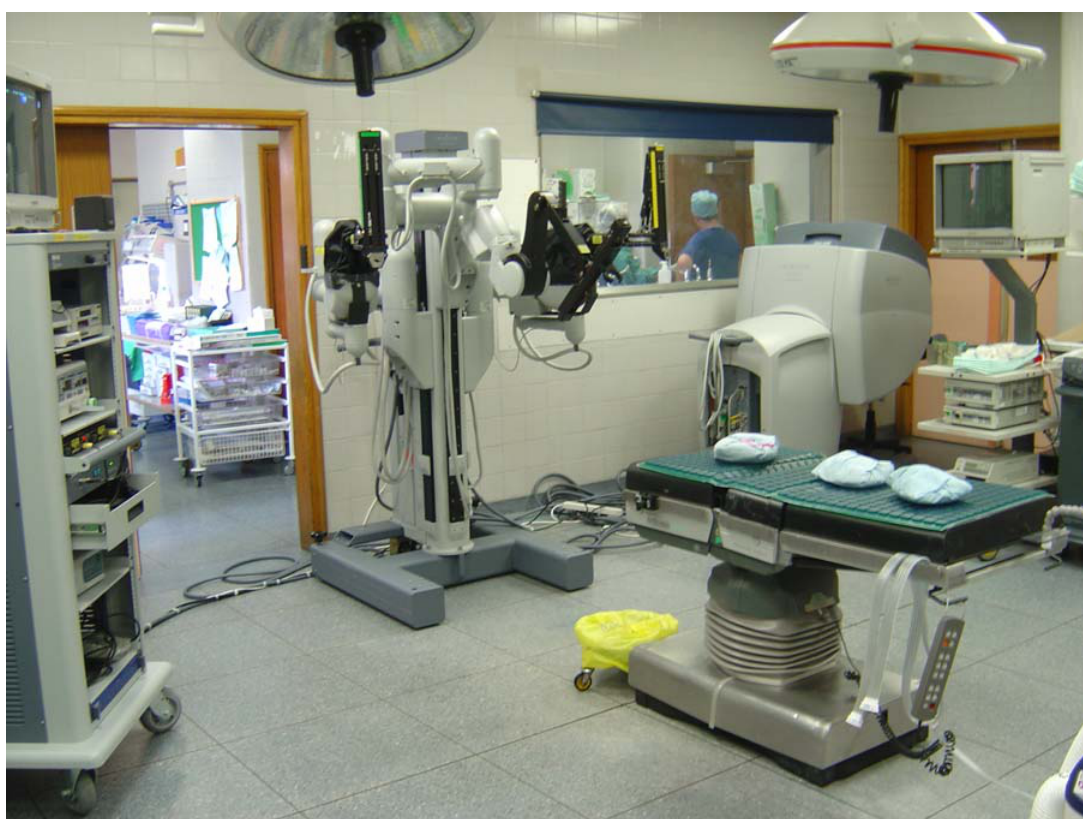
FIGURE 1 . da Vinci™ surgical system at Guy’s